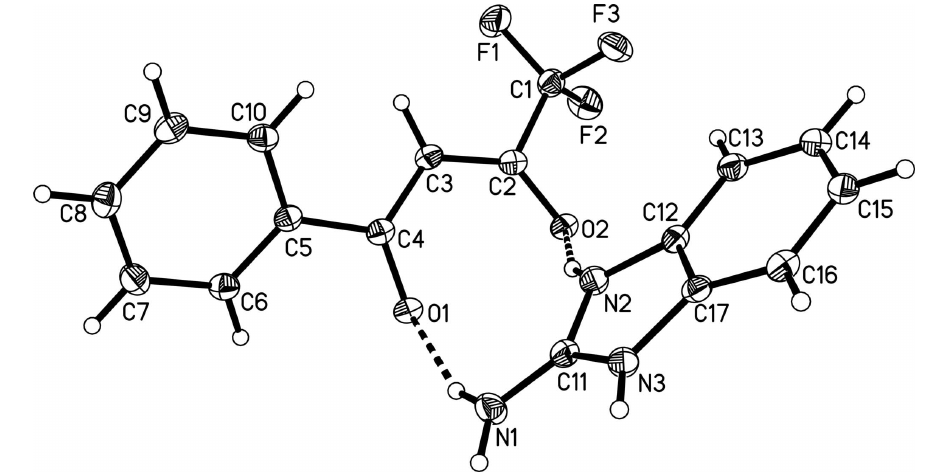
Figure 1 The asymmetric unit of the title compound, showing 30% probability displacement ellipsoids and the atom-numbering scheme. Hydrogen bonds are drawn as dashed lines.